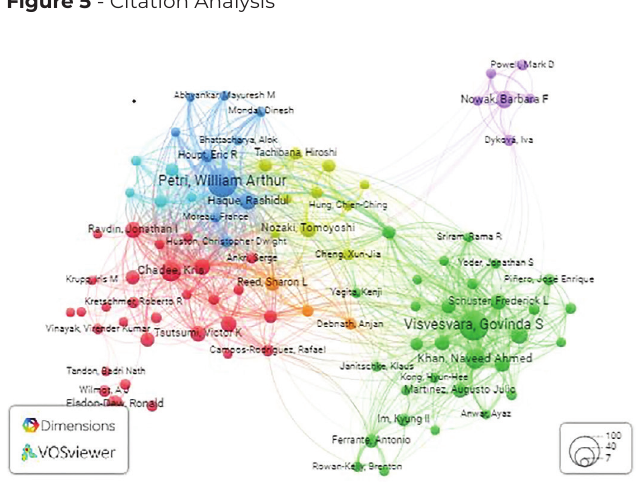
Figure 5 - Citation Analysis National Institute of Allergy and Infectious Diseases